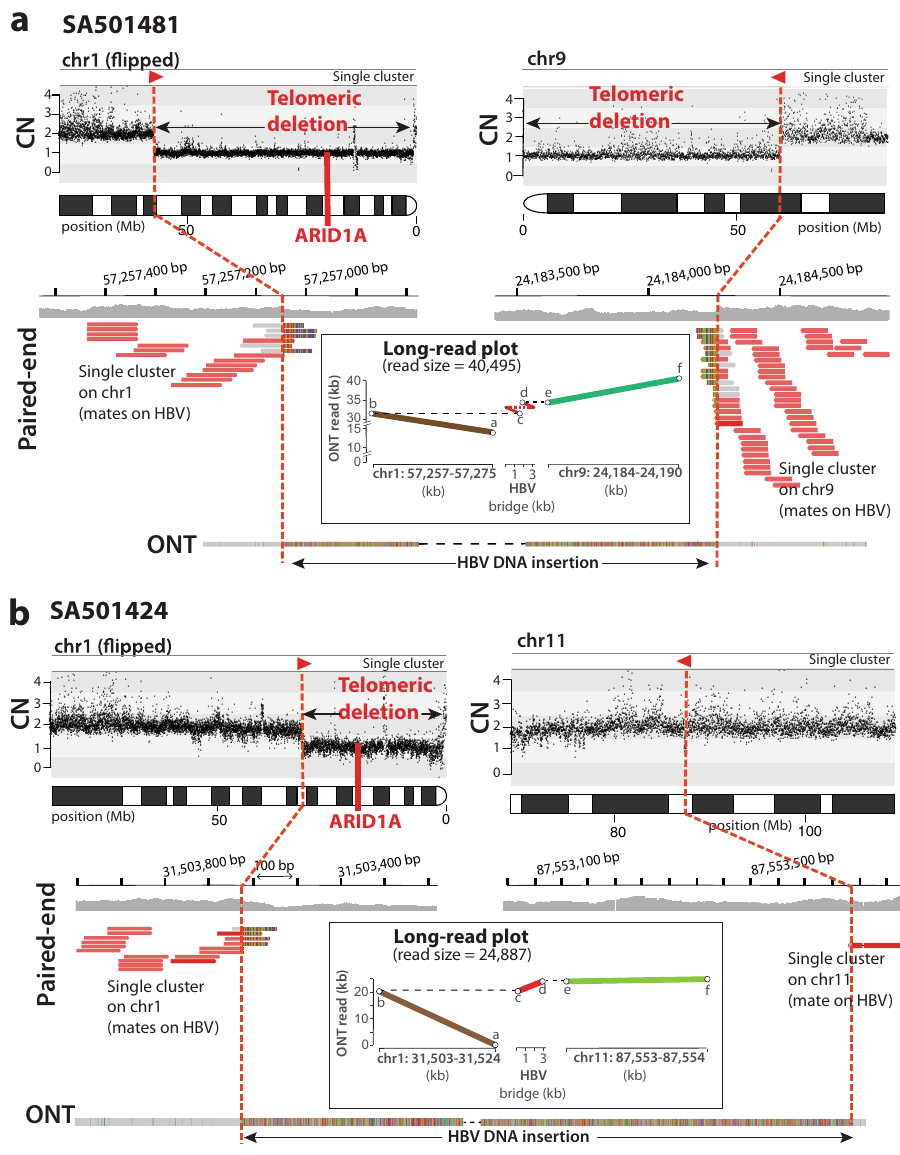
Fig. 7 HBV-mediated translocations lead to recurrent loss of tumour suppressor gene ARID1A . a In HCC tumour SA501481, the Illumina paired-end data (short-reads in red) shows two clusters, one on chromosome 1 and another on chromosome 9, which point to both extremes of an HBV insertion. The copy number (CN) plot at the top shows the total (gold line) and minor (grey line) chromosomes ’ copy number pro fi les. The CN plot reveals two telomeric deletions associated with HBV events, one that removes 57.2 Mb on 1p, including one copy of the ARID1A tumour suppressor gene, and a second deletion that removes 21.2 Mb on 9p. Note the CN plot from chromosome 1 is fl ipped for illustrative purposes. The long-read plot shows a 2688bp HBV insertion that bridges an interchromosomal rearrangement between chromosomes 1p and 9p. The con fi guration of the rearrangement predicts the formation of a dicentric chromosome (Fig. 3b). b A similar scenario, in tumour SA501424, where an HBV DNA insertion induces an interchromosomal translocation between chromosomes 1 and 11. The Illumina paired-end data (short-reads in red) shows two single clusters, one on chromosome 1 and another on chromosome 11, which point to both extremes of an HBV insertion. The CN plot at the top reveals a 31.5 Mb telomeric deletion on 1p associated with the HBV insertion event (note that the CN plot from chromosome 1 is fl ipped for illustrative purposes). Here, the associated telomeric deletion on chromosome 1 removes one copy of tumour suppressor gene ARID1A . The long-read alignment plot demonstrates an interchromosomal rearrangement between chromosomes 1 and 11 mediated by an HBV insertion. The long-reads used to construct the long-read plots are annotated in Supplementary Table 1. addition, the pair is also excluded if any of the reads is not a primary is ≤ 200 bp. Two main cluster categories are de fi ned, namely POSITIVE and alignment, fails platform/vendor quality checks, or is PCR or optical NEGATIVE (i.e., anchor reads are mapped onto the positive and negative duplicate. Non-anchor reads must not contain unsequenced nucleotides strand, respectively). A preliminary range of genome coordinates is ( ‘ N ’ ) and MAPQ of non-anchor ABERRANT reads must be < 20. The associated with each single cluster – fi nal breakpoint coordinates are re fi ned algorithm dustmasker v2.6.0 41 is used to identify non-anchor read-pairs in a later step – . Ranges are de fi ned by a lower (left) coordinate (P_L_POS containing low complexity sequences, which are later discarded. and N_L_POS, respectively for positive and negative clusters) and an upper (2) Clustering (right) coordinate (P_R_POS and N_R_POS, for positive and negative). Anchor reads are clustered together if (i) they share the same orientation, Only clusters consisting of ≥ 4 supporting reads are considered for further analysis. To avoid miscalls due to alignments in complex regions, the full set and (ii) the distance relative to the nearest mapped read of the same cluster NATURE COMMUNICATIONS| (2021) 12:6910